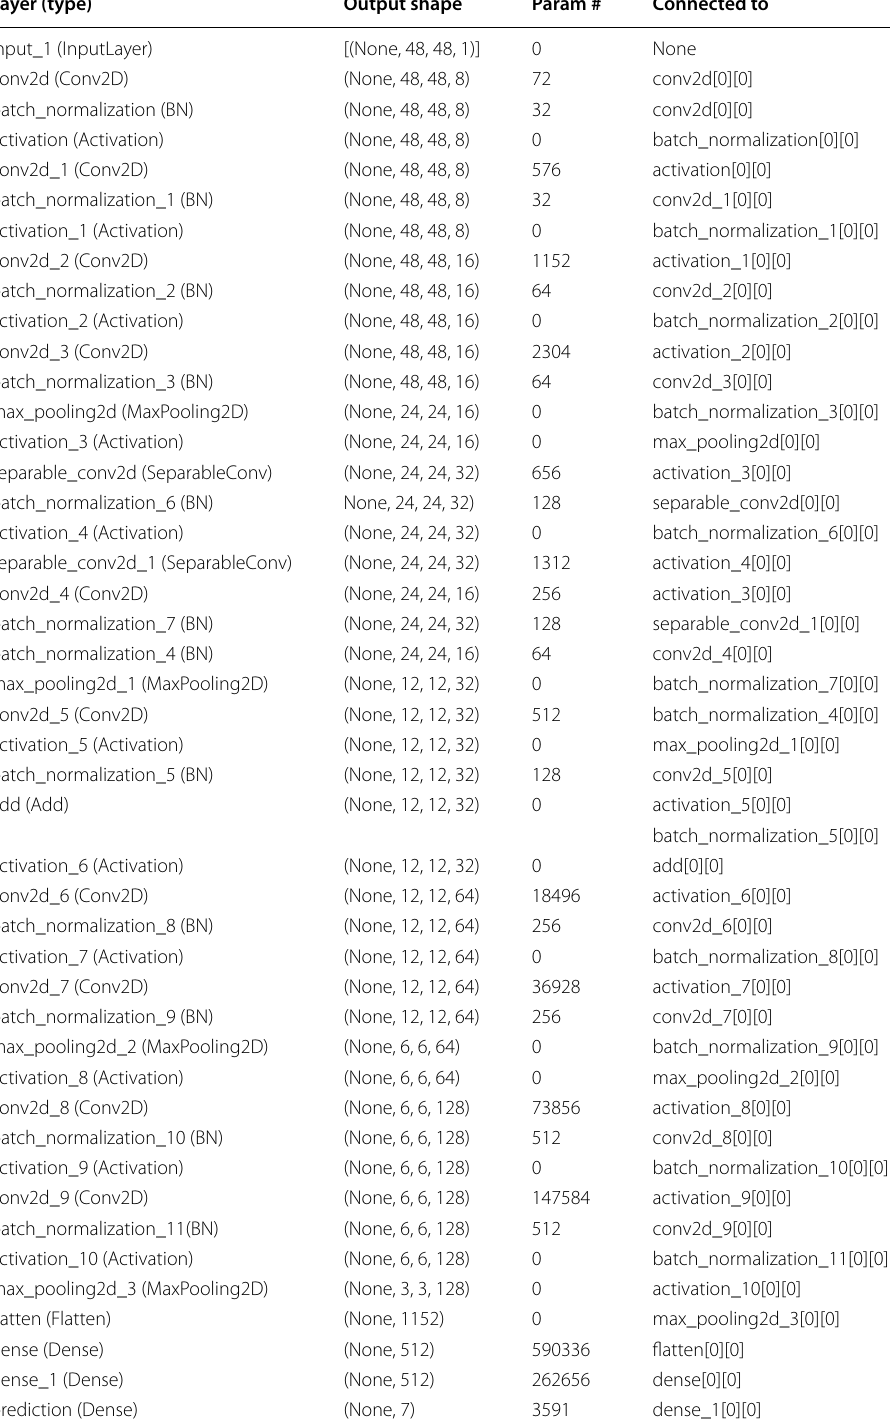
Table 2 Architecture with separable convolution and dense layers